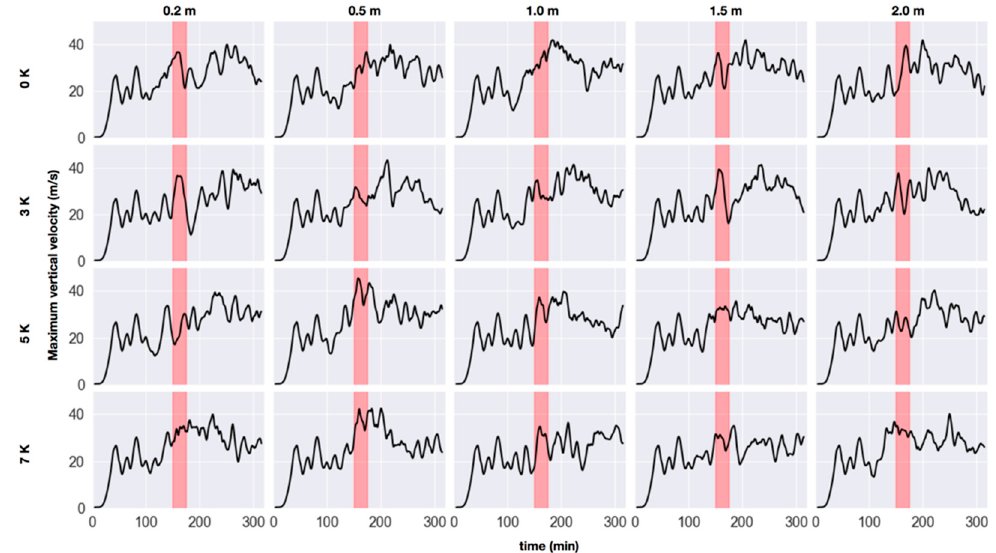
Figure 3. Domain maximum vertical velocity in each simulation. Values are smoothed using a 10-point moving filter using data with a 1-min temporal resolution. The red rectangle highlights the time period when the storm is passing over the idealized city.